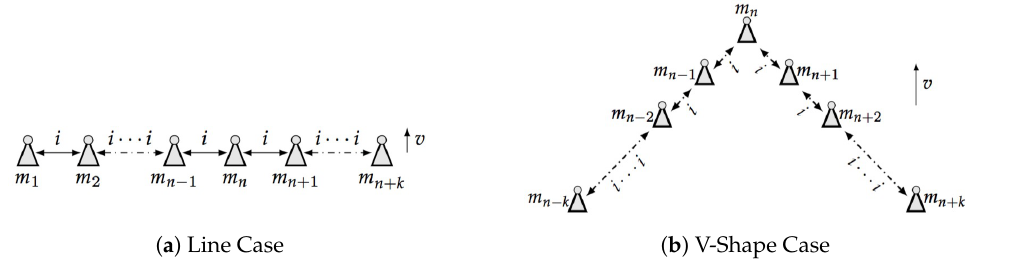
Figure 1. Desired Distributed Processing